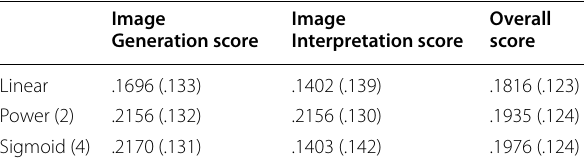
Standard error of the estimate is presented in